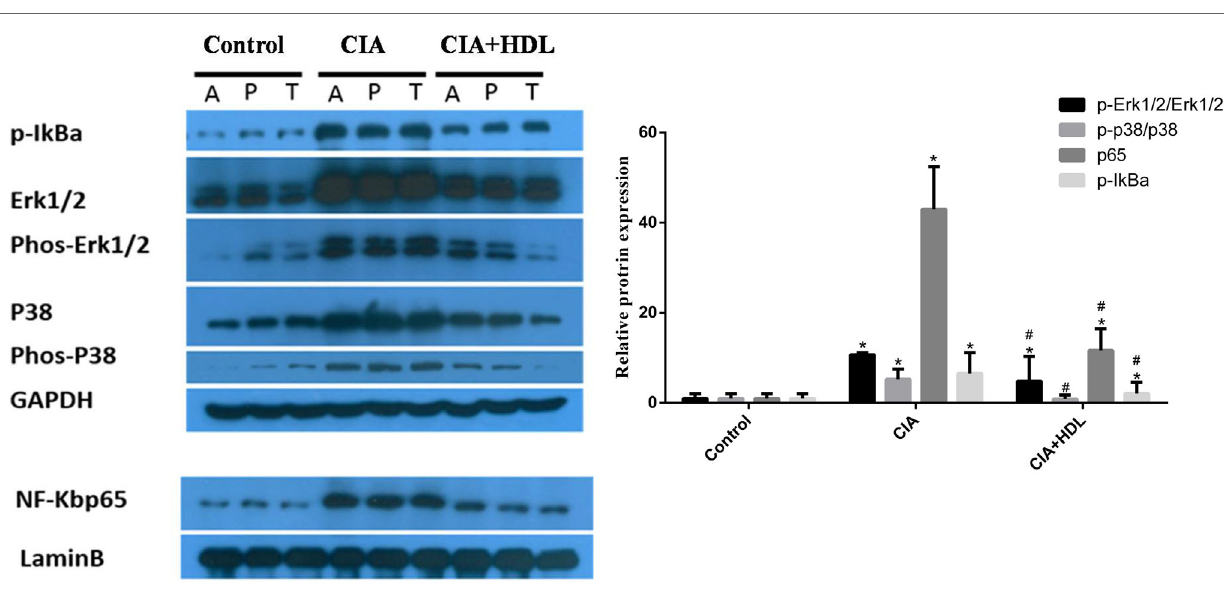
FigUre 5 | High-density lipoprotein (HDL) inhibits the inflammatory pathway induced by collagen. Compared with the collagen-induced arthritis (CIA) group, we found that HDL could inhibit the activation of the ERK, P38, and NF-kB inflammatory pathway based on their expression levels. # p < 0.05 vs. CIA group; *p < 0.05 vs. control